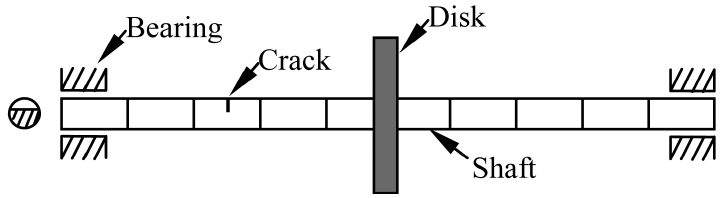
Fig. 1. Rotor system with one cracked